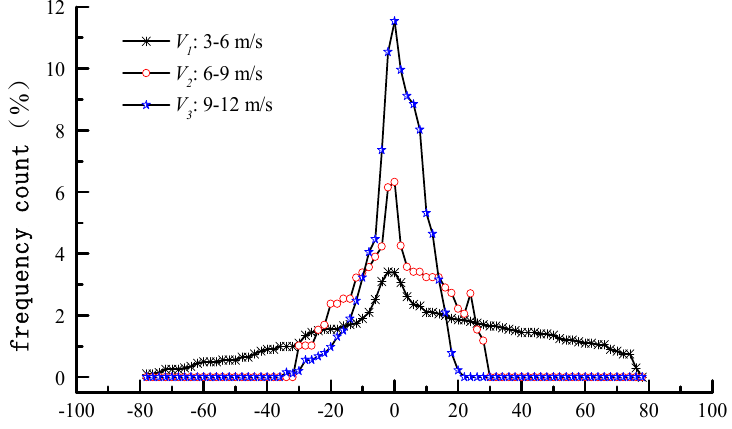
Figure 11. Error distribution of output power under different wind speed.